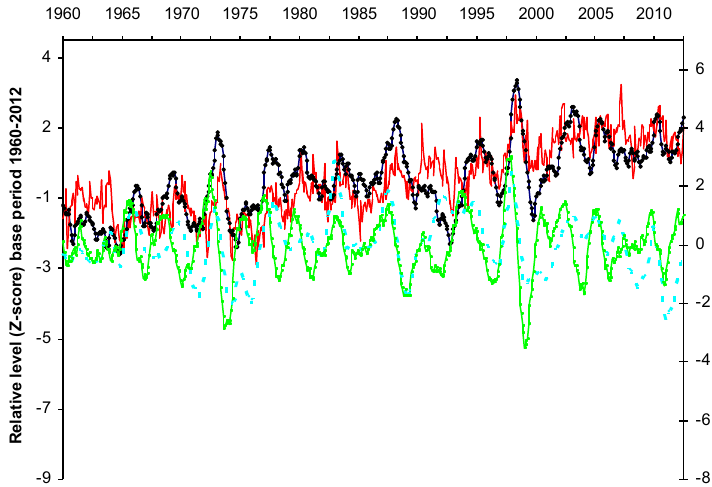
Figure 6. Z scored monthly data: global surface temperature (red curve) and first-difference atmospheric CO 2 smoothed by two 13-month moving averages (black dotted curve ) (left-hand scale); sign-reversed SOI smoothed by a 13-month moving average (blue dashed curve) and second-difference atmospheric CO 2 smoothed by three 13-month moving averages (green barred curve) (right-hand scale). Table 6. Pairwise correlations (correlation coefficients ( R )) between selected climate variables, phase-shifted as shown in the table. Led2m2x13mmafirstdiffCO 2 Hadcrut4Global Led4m3x13mma2nddiffCO 2 Hadcrut4Global 0.71 1 Led4m3x13mma2nddiffCO 2 0.23 0.09 1 13mmaReverseSOI 0.16 0.14